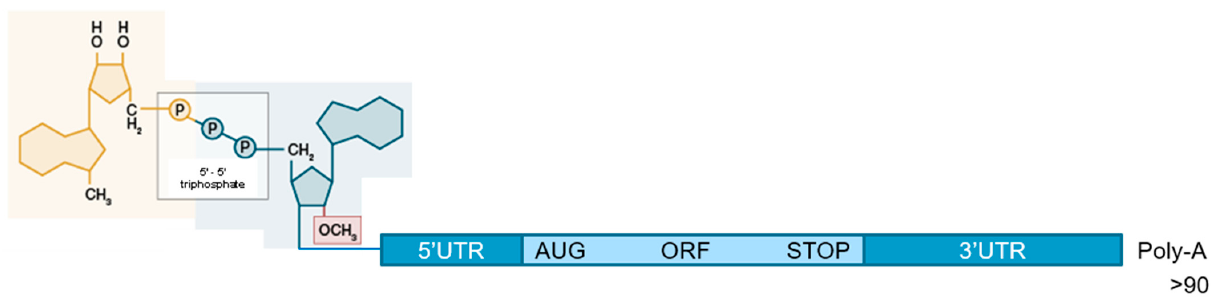
Figure 1. The structure of the in vitro transcribed (ivt) mRNA. The mRNA starts with a cap structure, followed by an untranslated region (5 ′ UTR) up to the start codon. Between the start and stop codon is the coding sequence. This is followed by the 3 ′ UTR and a poly-A tail.